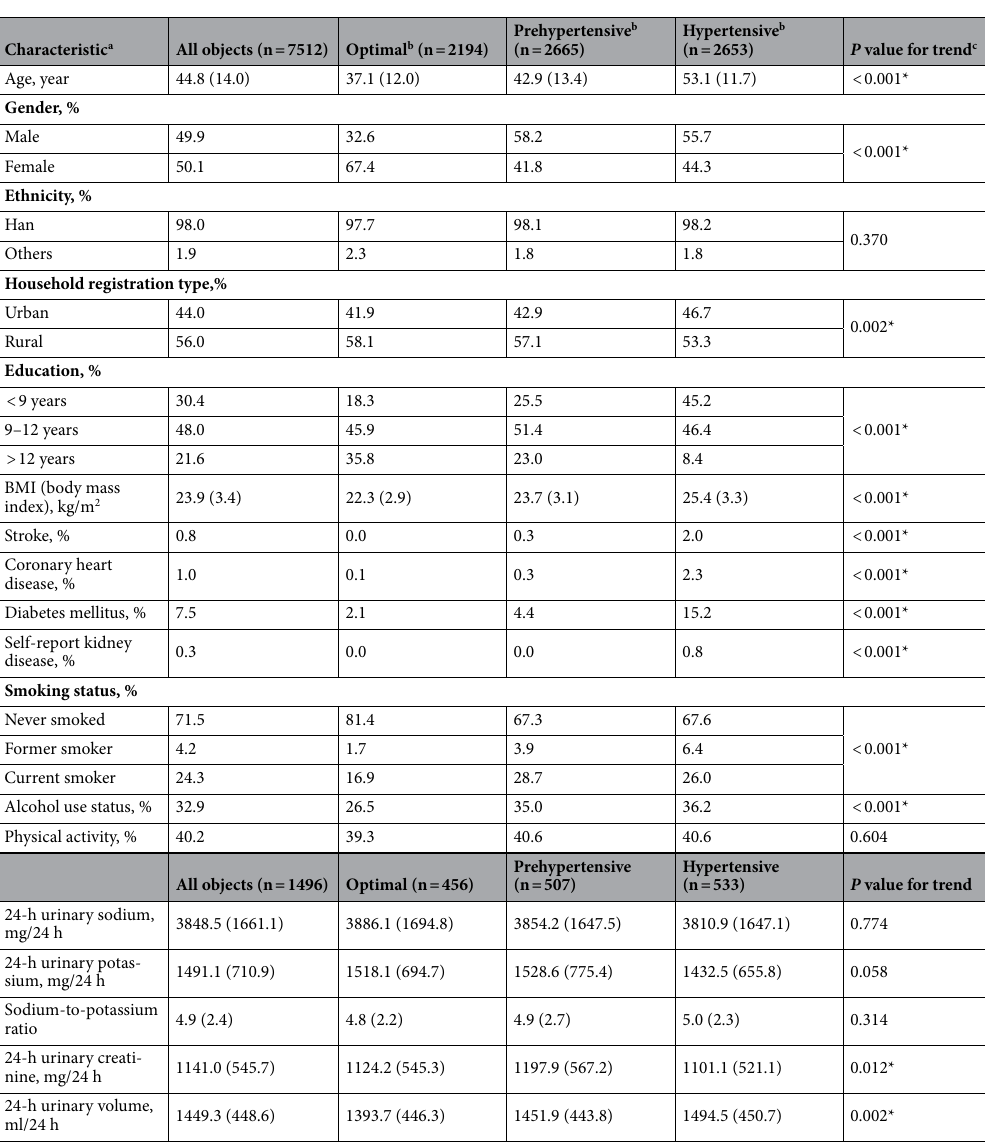
hypertensive patients is 34.7% b Hypertension defined as mean SBP ≥ 140 mm Hg, and/or mean DBP ≥ 90 mm Hg, and/or self-reported use of antihypertensive medication. Prehypertension defined as mean SBP 120– 139 mm Hg or mean DBP 80–89 mm Hg. Optimal blood pressure was defined as mean SBP < 120 mm Hg and mean DBP < 80 mm Hg. Mean blood pressure was estimated from up to 3 readings during the physical examination in our baseline survey. c Kruskal-Wallis test is used to compare the characteristics of different hypertensive status. * P value for trend <